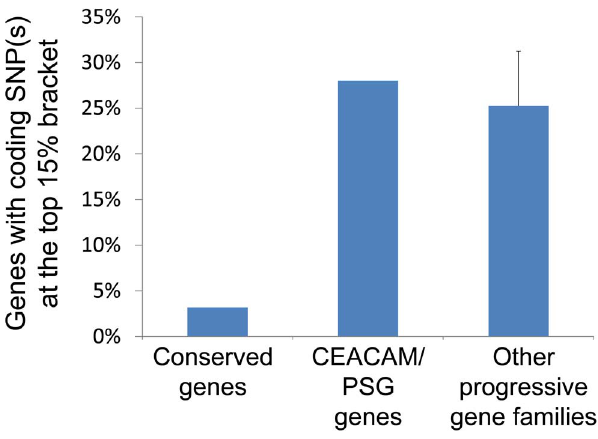
Figure 6. The CEACAM/PSG and three other progressive gene families (sialic acid binding Ig-like lectin, leukocyte immuno- globulin-like receptor, and olfactory receptor) have a higher percentage of genes containing a nonsynonymous SNP with F ST scores in the top 15% bracket as compared to that of the rest of genes (conserved genes) on chromosome 19. Progressive gene families are those encoded secreted ligands or cell surface receptors, and expanded multiple times during primate